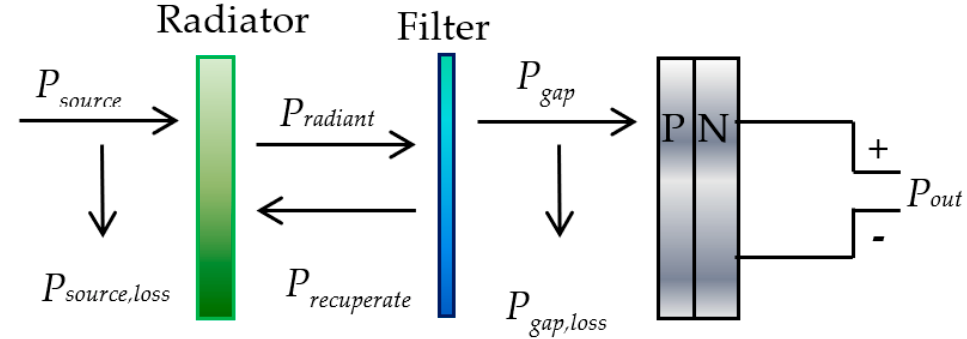
Figure 1. Schematic diagram of an overall TPV system.